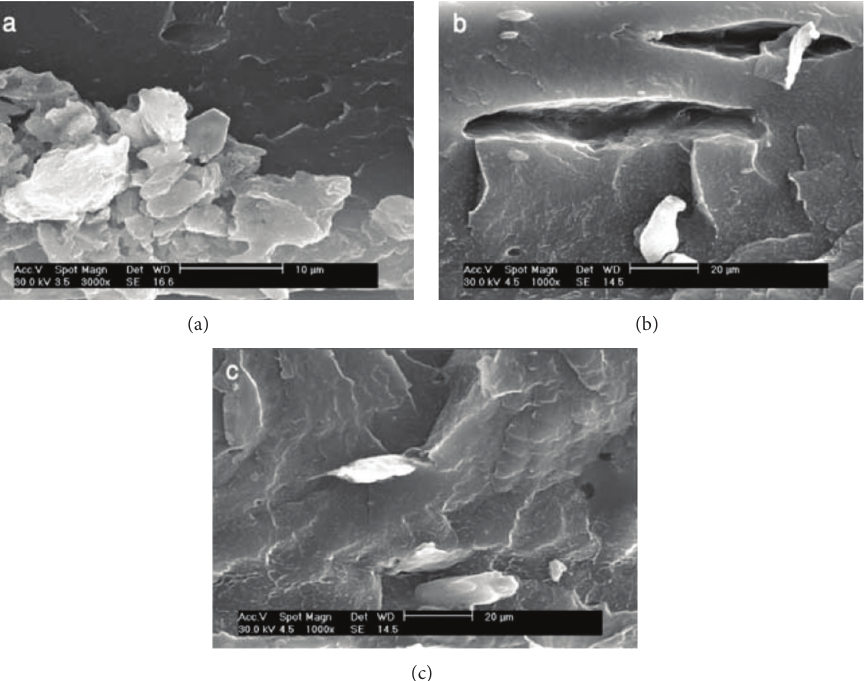
Figure 3: SEM micrographs of the fractured surface of composites films with varying compatibilizer concentrations: (a) 0, (b) 2, and (c) 6 PPH [42].